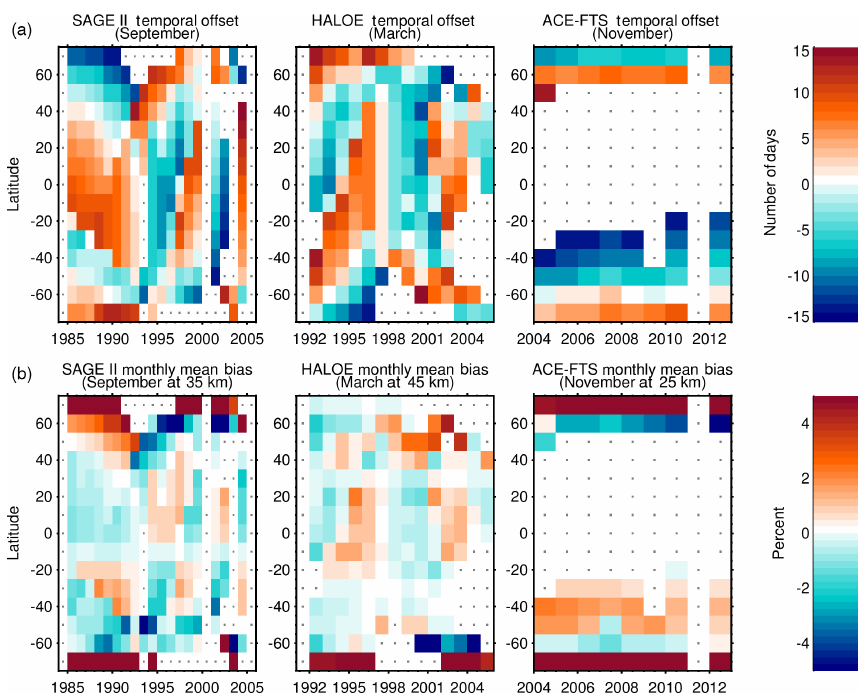
Figure 6. (a) The MZM temporal sampling bias shown as the difference between the average time of sampling in a given month and latitude band and the center of that month. Results shown here are for different months and different data sets, though systematic biasing of results is common for most months for each data set. (b) The MZM seasonal sampling bias shown as the difference in ozone between the actual center of sampling for a given month and latitude band and the center of that month and band as computed using the seasonal cycle and the local mean from the STS regression. Results are shown here for different altitudes illustrating the pervasiveness of the